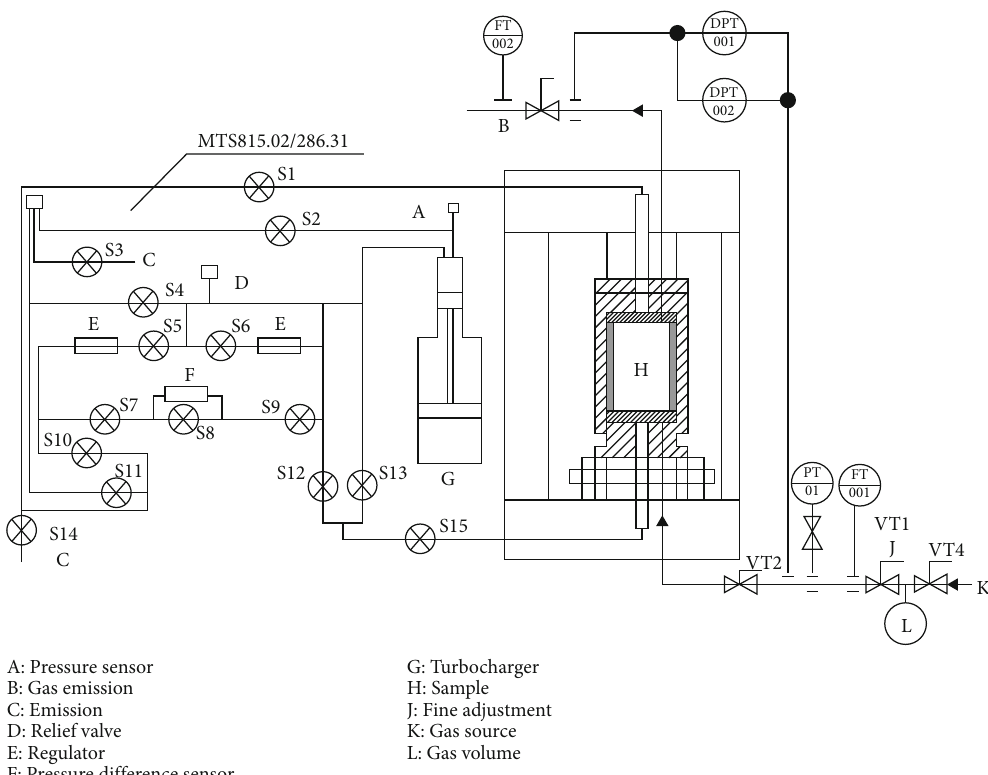
Figure 4: Schematic diagram of rock gas permeability test under unloading con fi ning